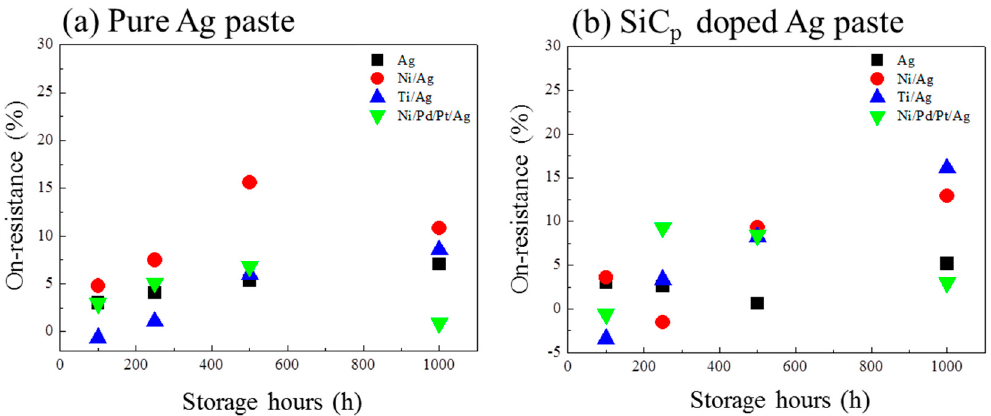
Figure 7. Evolution of the on-resistance of ( a ) pure Ag paste and ( b ) SiC p -doped Ag paste on various substrates.